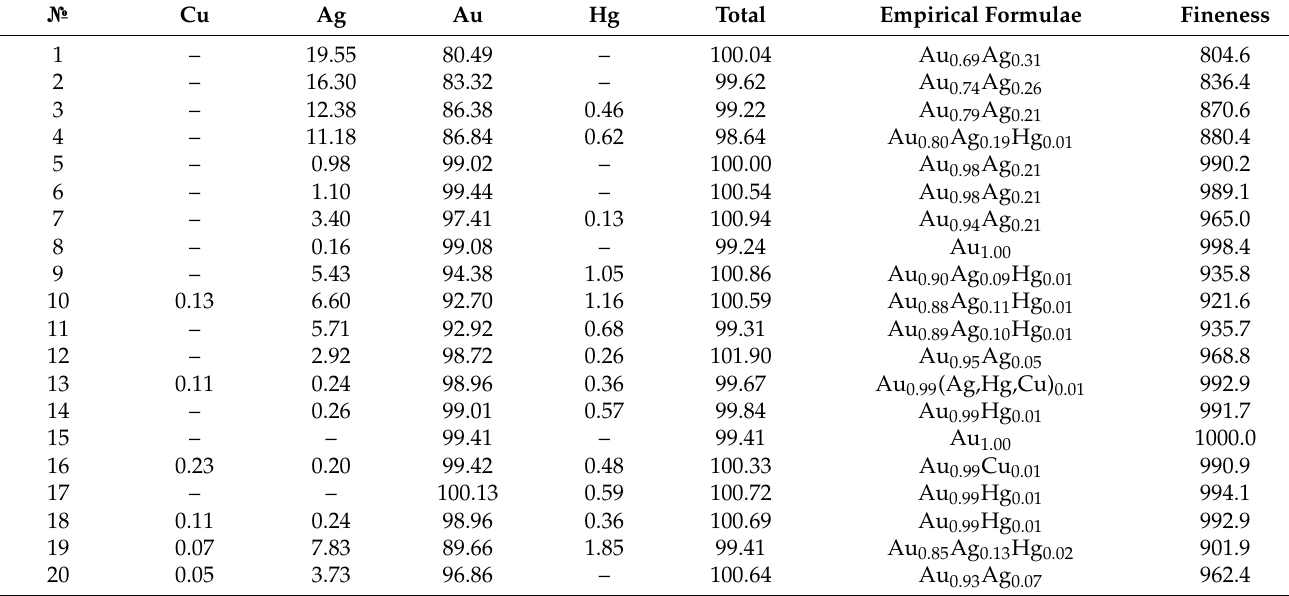
Table 3. The chemical composition of native gold from breccias with realgar-orpiment cement, wt. %. (fineness in ‰).